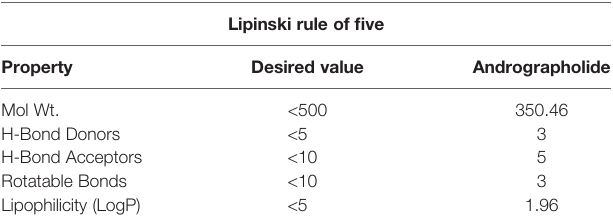
TABLE 2 | Drug-likeness (Lipinski rule of fi ve) for andrographolide. Lipinski rule of fi